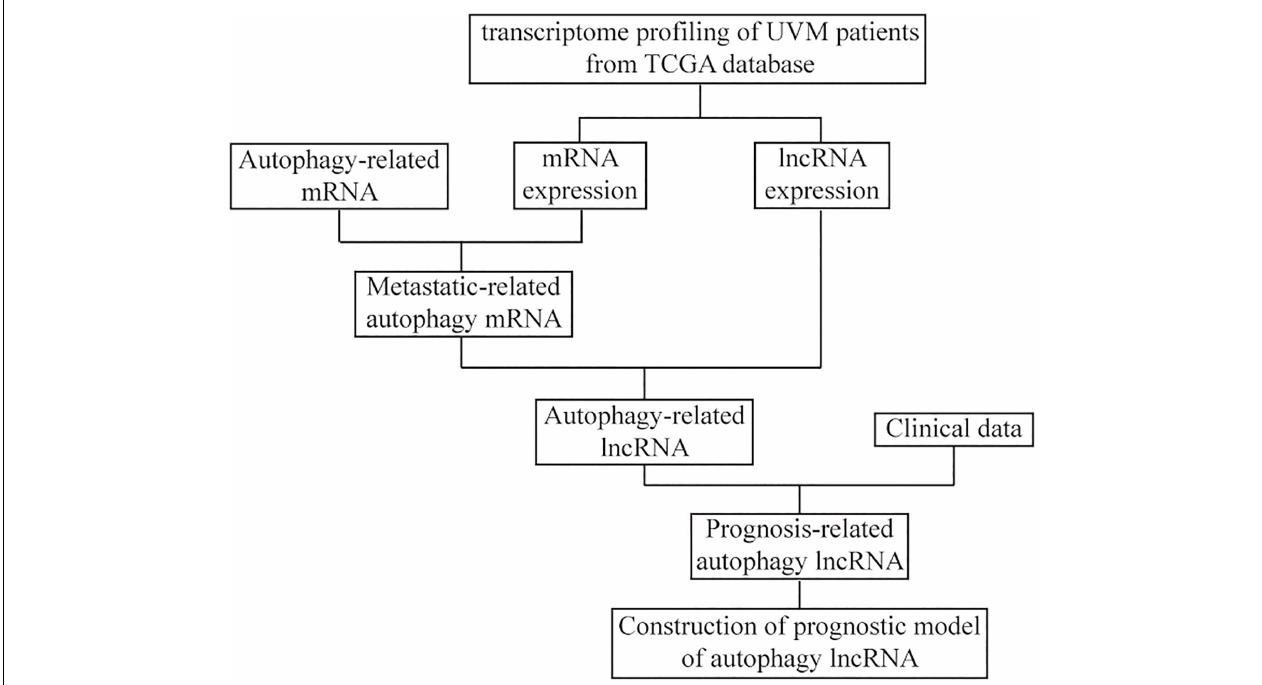
FIGURE 1 | The flowchart of the construction of the prognostic model of autophagy long non-coding RNA (lncRNA) in uveal melanoma (UM).